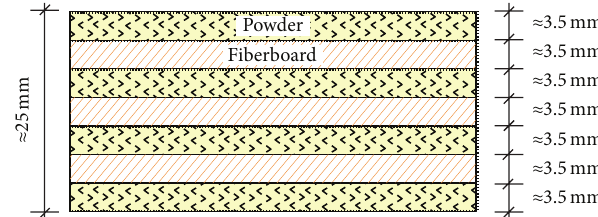
Figure 4: Structure of the composite core investigated by NRC-IRC